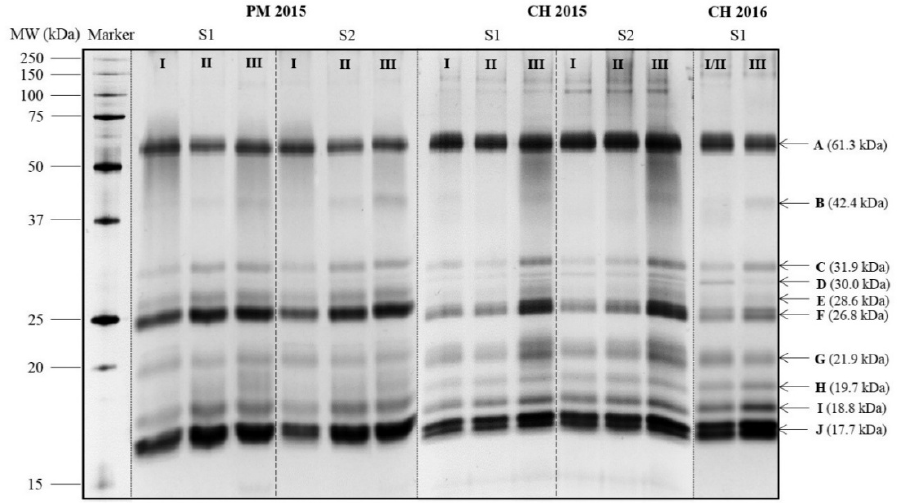
Figure 1. SDS–PAGE of Pinot meunier (PM) and Chardonnay (CH) Champagne base wine proteins from different grape maturity levels by silver staining.